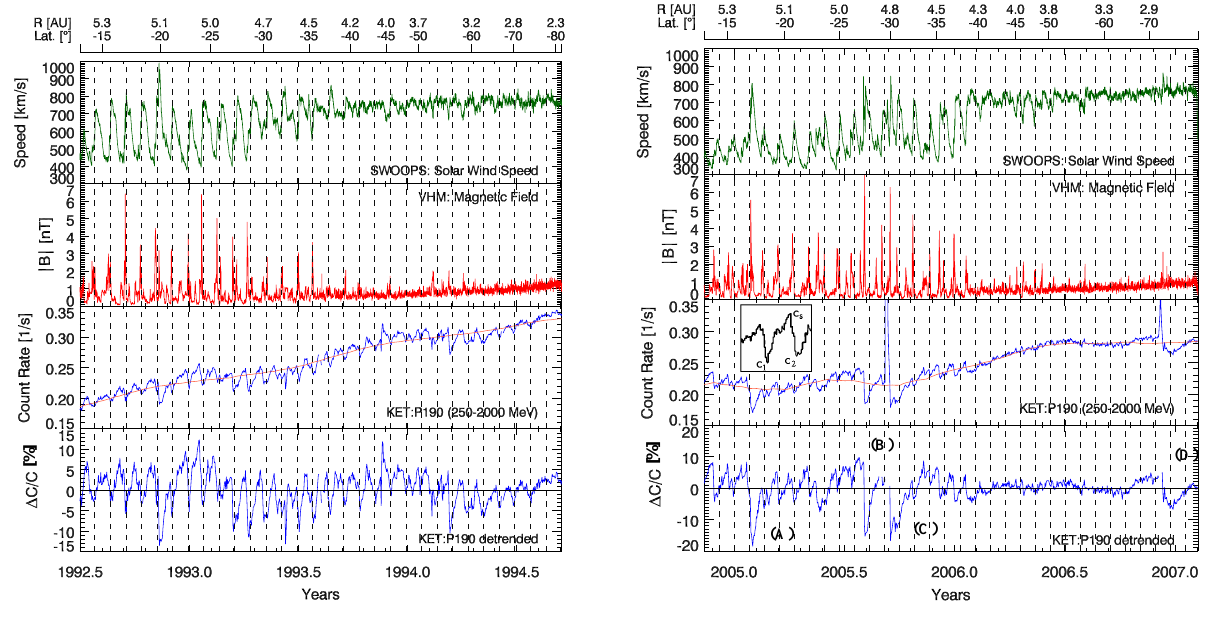
Fig. 3. Ulysses measurements during the intervals C22 (left panel) and C23 (right panel). The panels display from top to bottom hourly averages of the solar wind speed (green), the magnetic field strength (red), daily (blue) and 26-day-running mean-averaged (red) count rates of 250–2000MeV protons as well as the long-term detrended galactic cosmic ray variation at Ulysses (blue). The labels on top of both panels give the radial distance and latitude of Ulysses’ orbit. The dashed vertical lines indicate periodicities of 26 days for C22 and 24.5 days for C23 with the second value resulting from the Lomb analysis shown below. The letters (A) to (D) indicate four prominent transient decreases in C23, whereas only one prominent event (at about 20 ◦ ) can be seen in C22. The insert in the right panel illustrates the procedure to determine the amplitudes of the GCR decreases, cf. Sect.